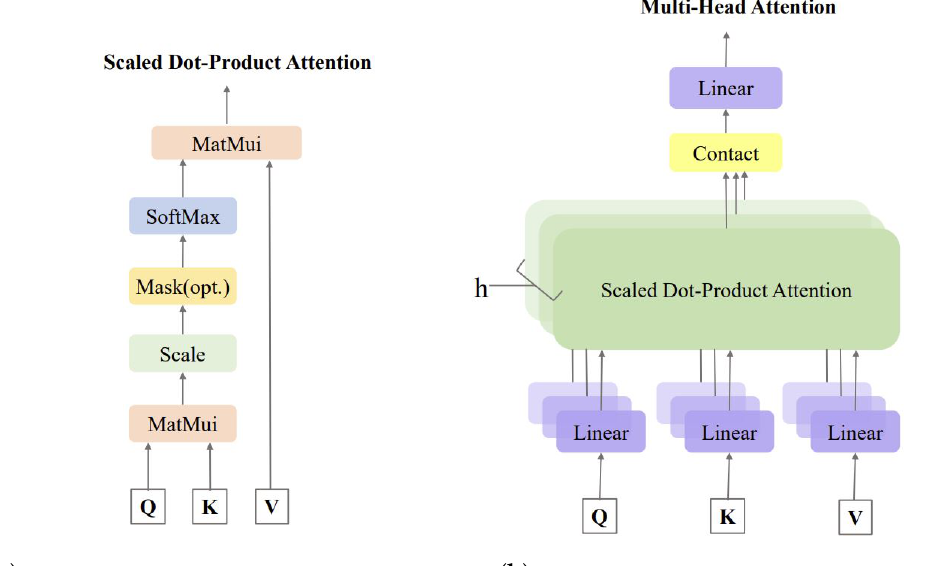
Figure 2. Process of multihead